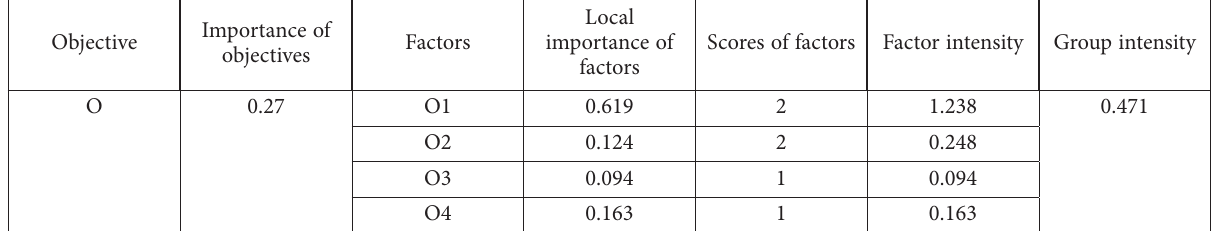
Table A4. Intensity for opportunity factors and groupings in SNC (one expert)